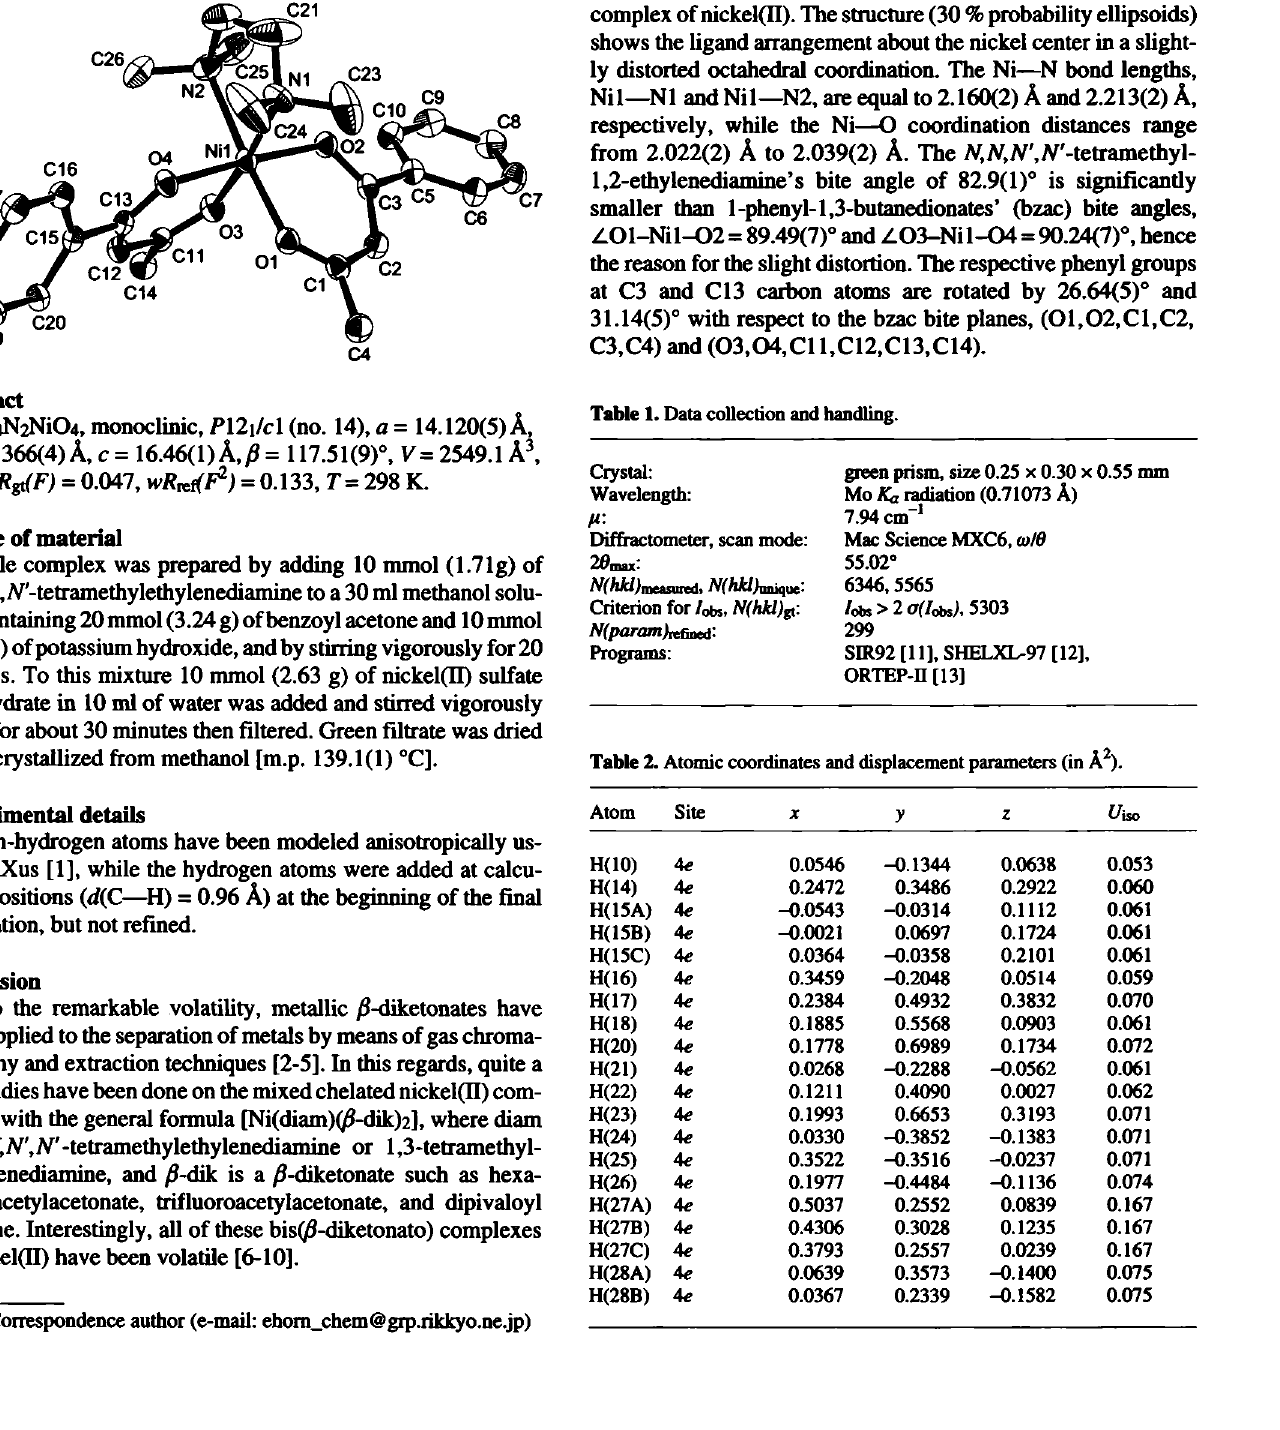
Table 1. Data collection and handling.